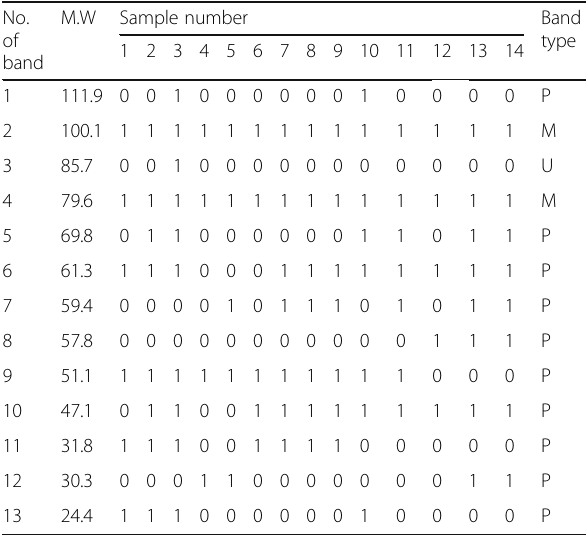
Table 4 The molecular weight obtained from protein electrophoresis of the investigated samples of Silybum marianum No. M.W Sample of band